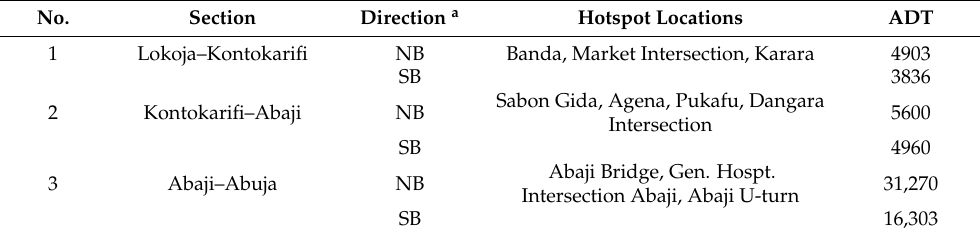
Table 5. Traffic data at hotspots.